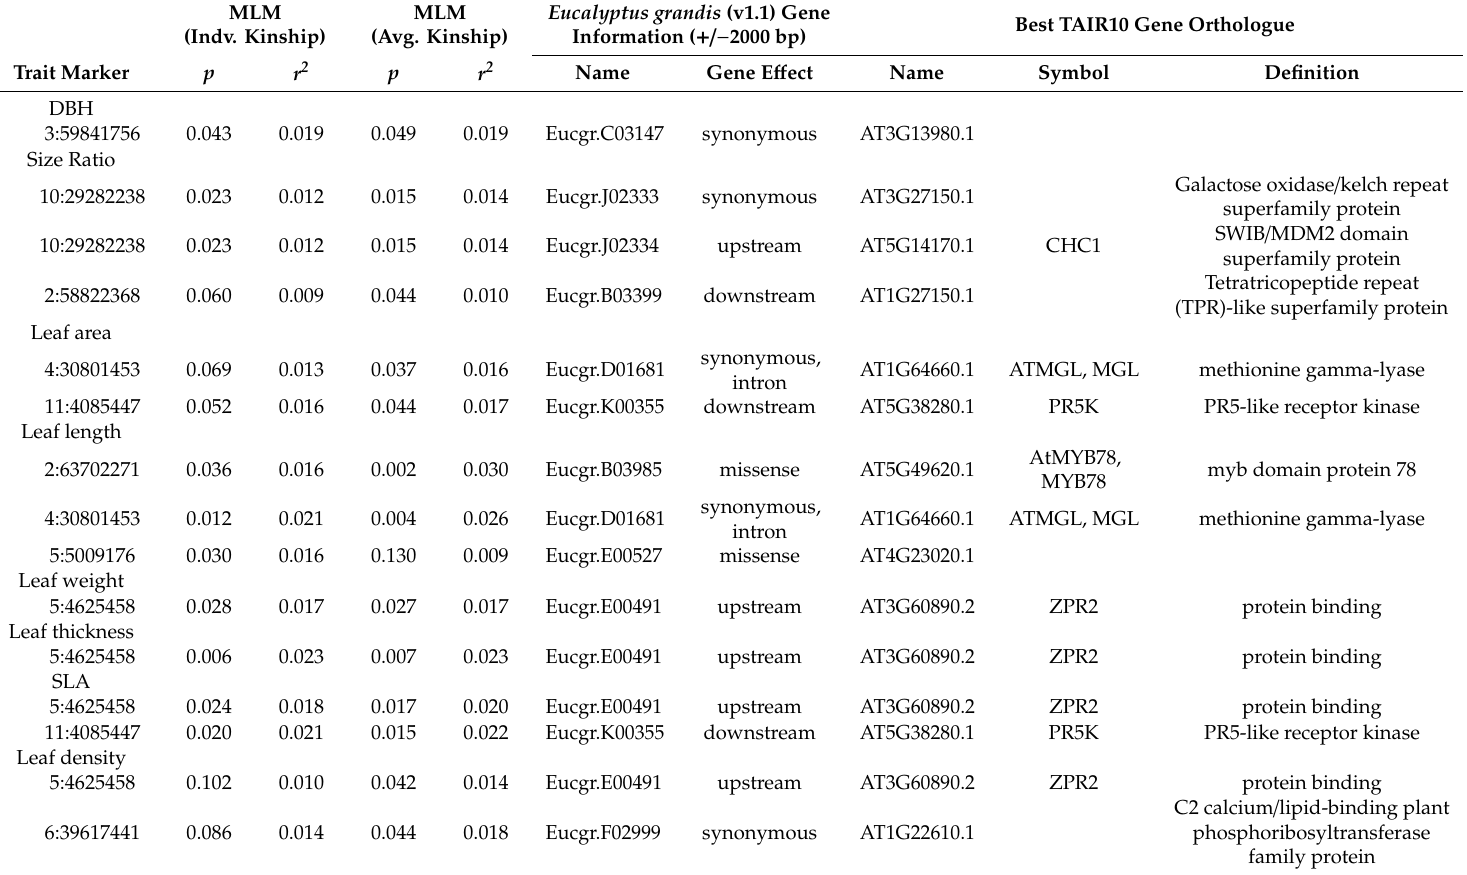
Table 5. Significant SNP-trait associations ( p < 0.05) in Eucalyptus microcarpa (Grey box)and possible gene function of SNPs based on Arabidopsis thaliana orthologues (TAIR10) of predicted E. grandis genes (information from E. grandis v1.1 genome annotation). Mixed linear models (MLM) accounted for kinship using either a kinship matrix based on individual kinship (indv. kinship) or family-average kinship (avg.